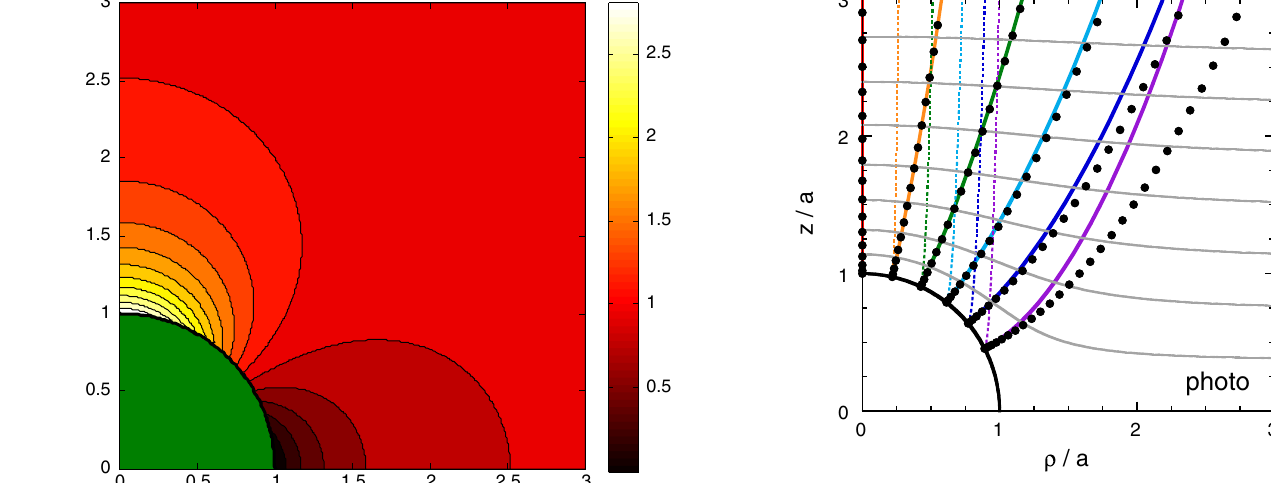
FIG. 11. Longitudinal field F respect to the background field F 3 cos 2 θ . The boss is the green hemisphere in the F =F z o ¼ lower